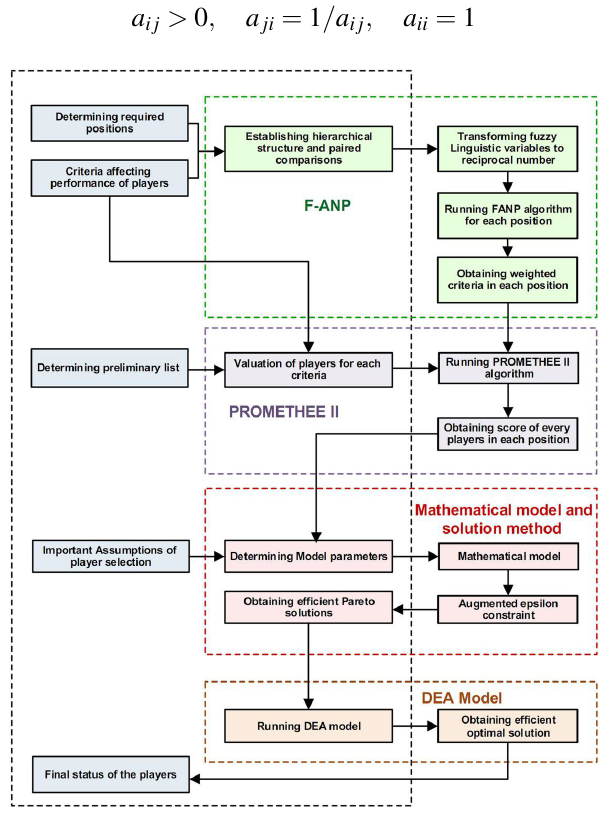
Fig. 2 Principle of AHP. AHP, analytic hierarchy